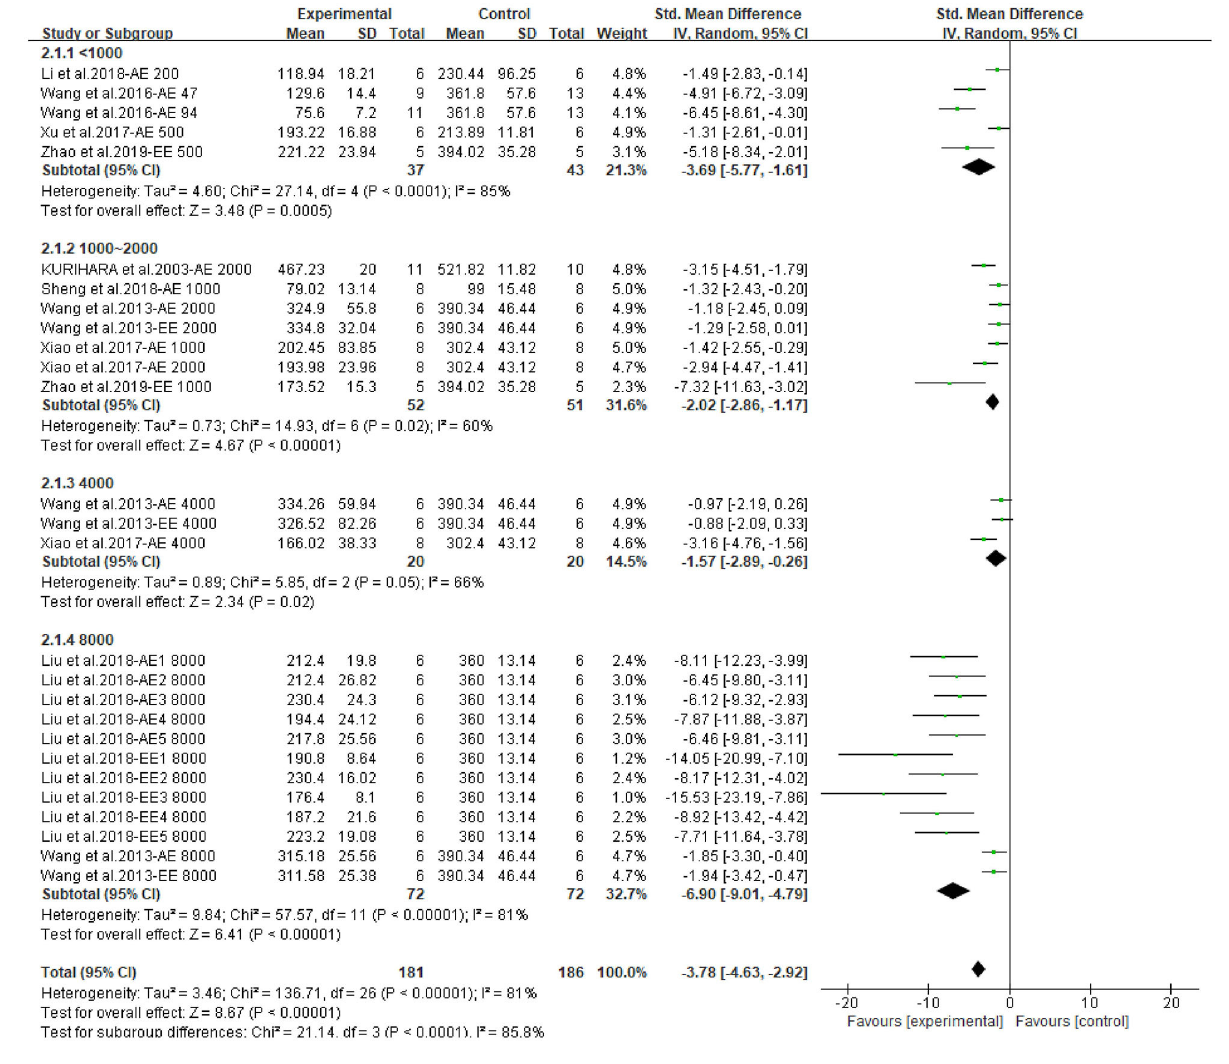
Frontiers in Nutrition |